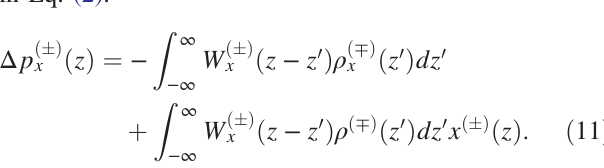
FIG. 2. Normalized cross wake force, W ffiffiffi p π ζ = 2 Im w ð ζ = 2 Þ , where ζ ¼ θ